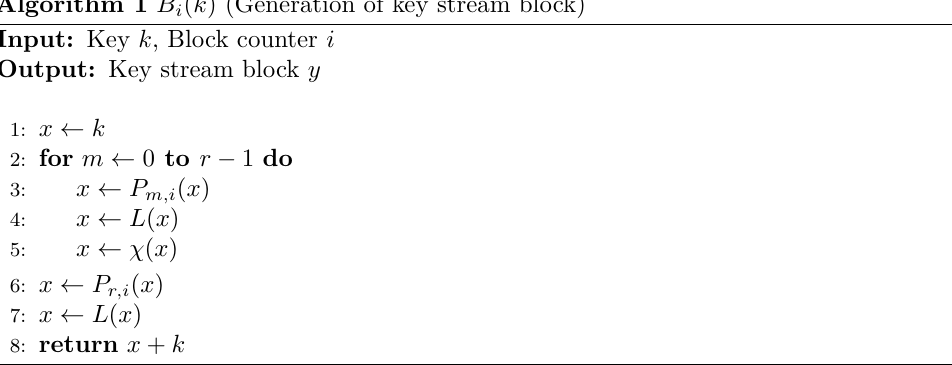
Algorithm 1 B i ( k ) (Generation of key stream